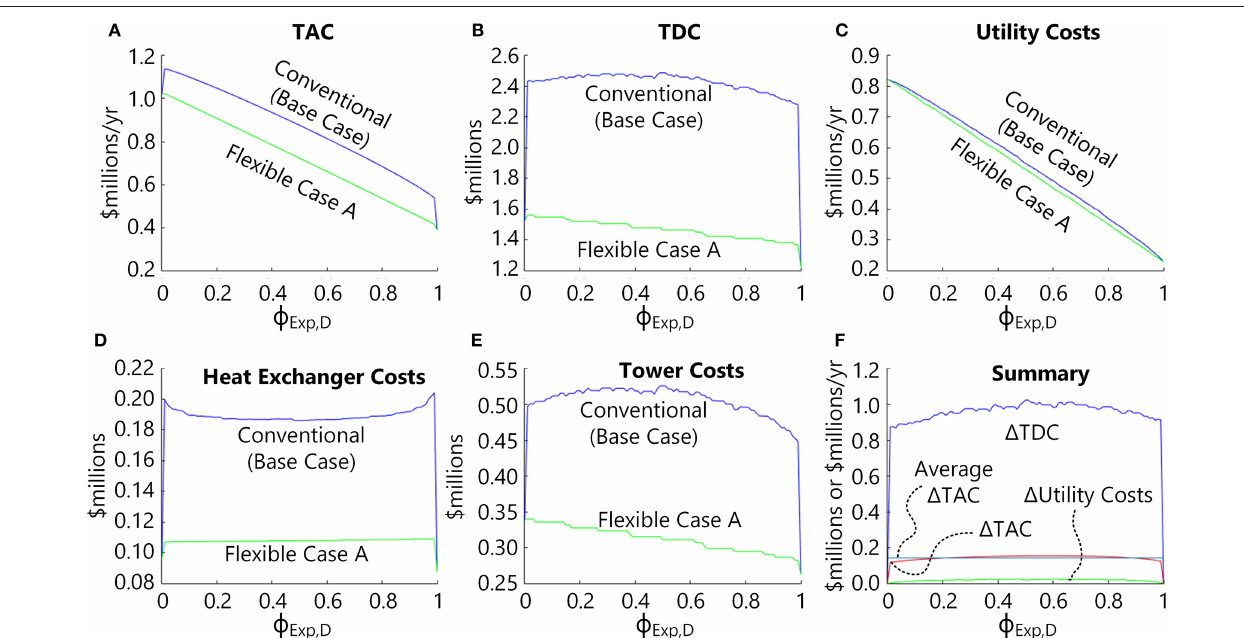
Frontiers in Energy Research | www.frontiersin.org